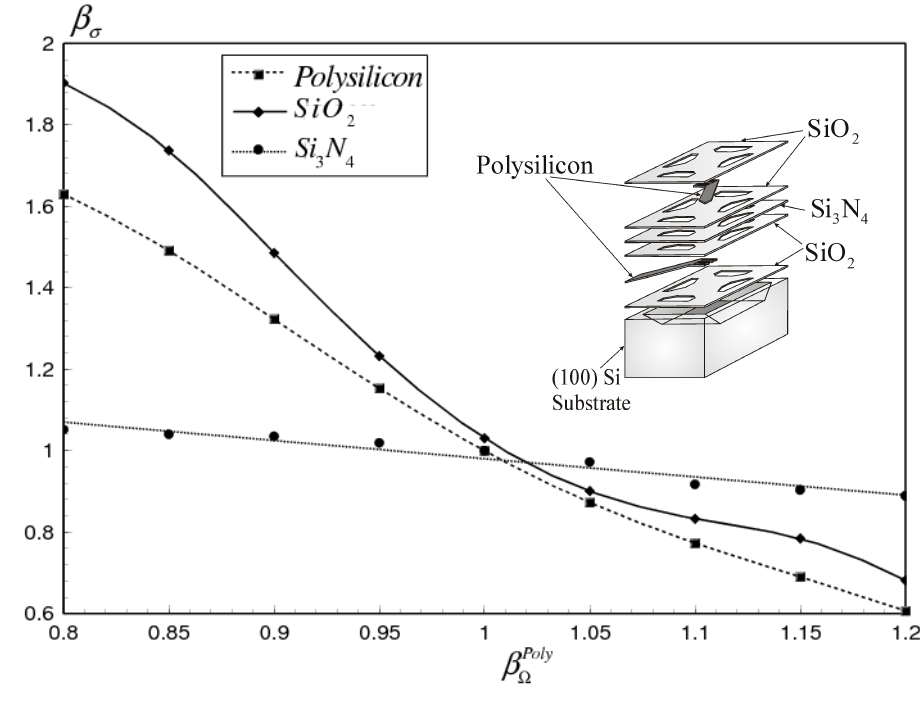
Figure 7. Effect of electrical resistivity variation of polysilicon on the maximum thermal stress of different gas sensor